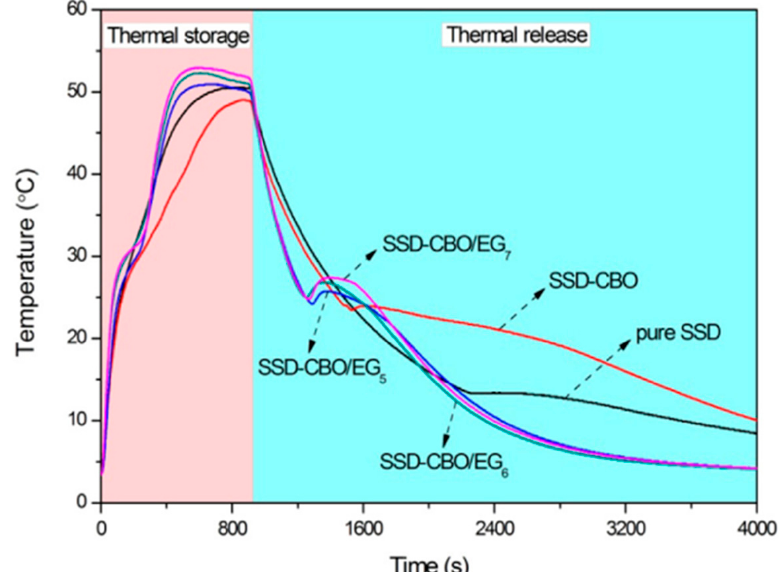
Figure 11. Energy storage/release of the GS-PCM with/without CBO and EG [90].